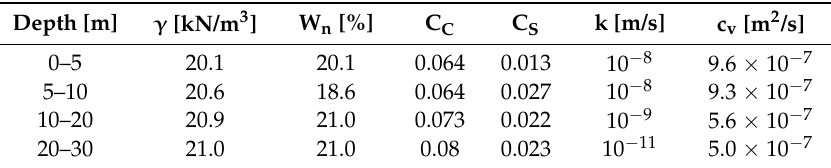
Table 6. Geotechnical features of laboratory tested